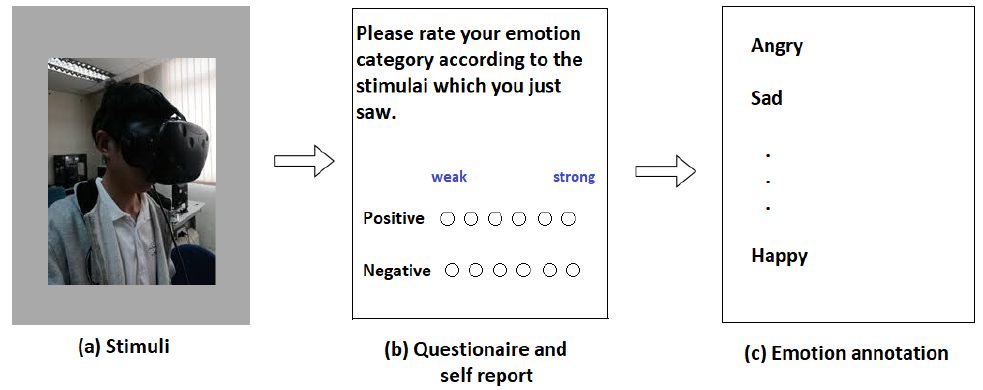
Figure 5. Steps involving discrete